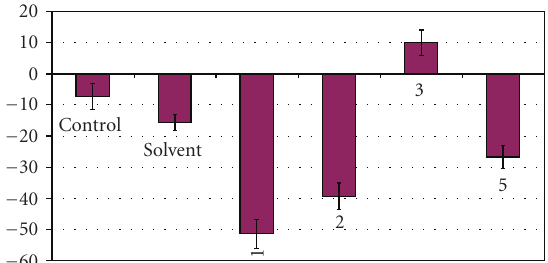
Figure 5: Change of the burnt surfaces after 21 days treatment with the solvent and complexes 1–3 and 5 in contrast to the burnt surface at 0